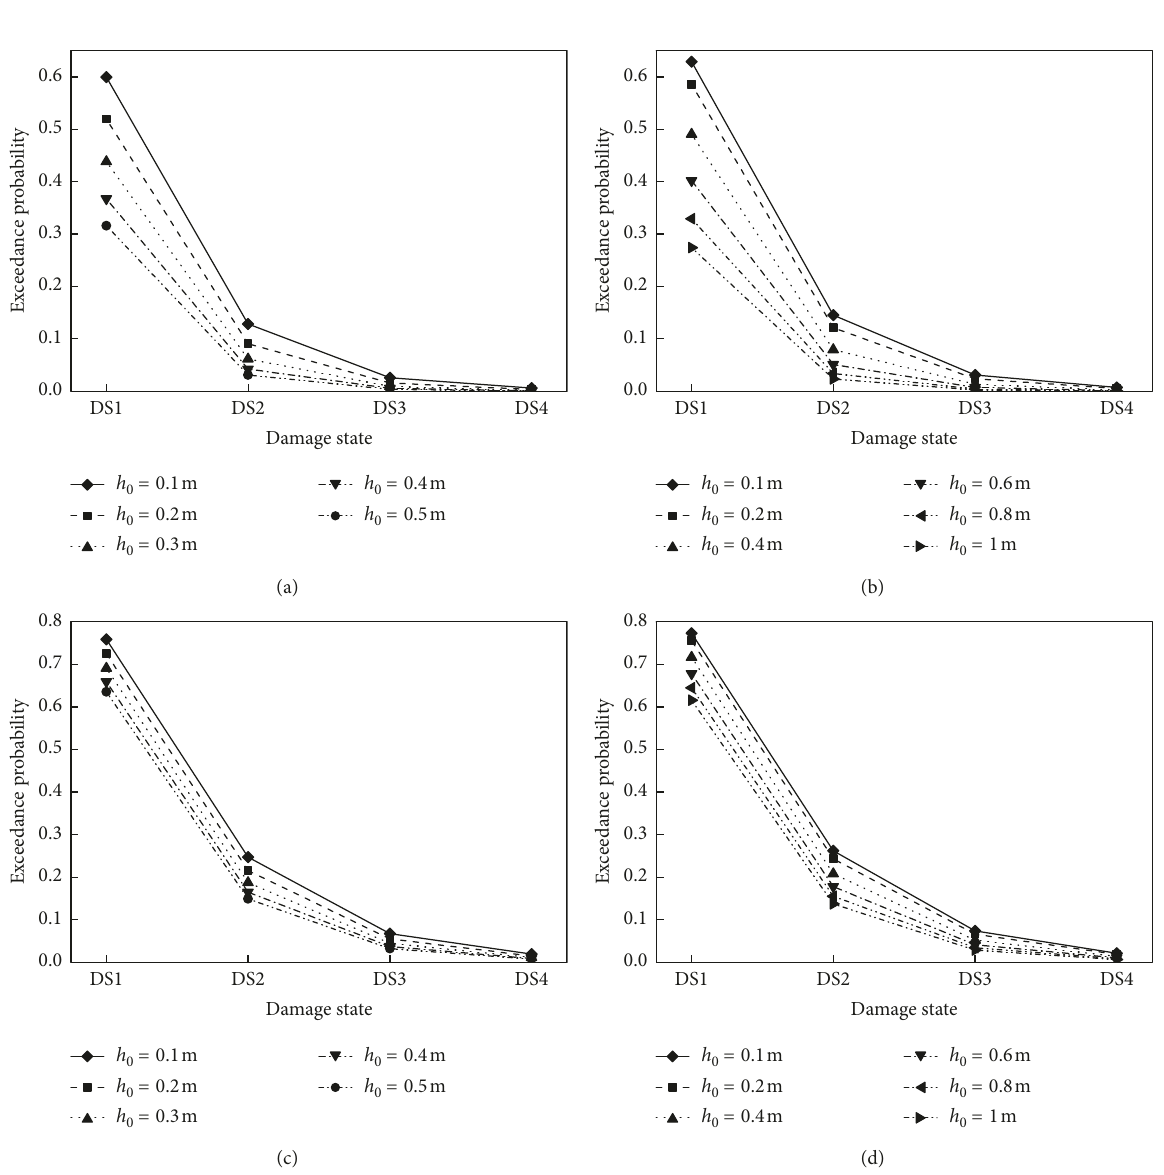
100kN/m with different damping constants, PGA (cid:31) 1 , h . 5m, C 0.0m 1 (cid:31) 0 (cid:31) −